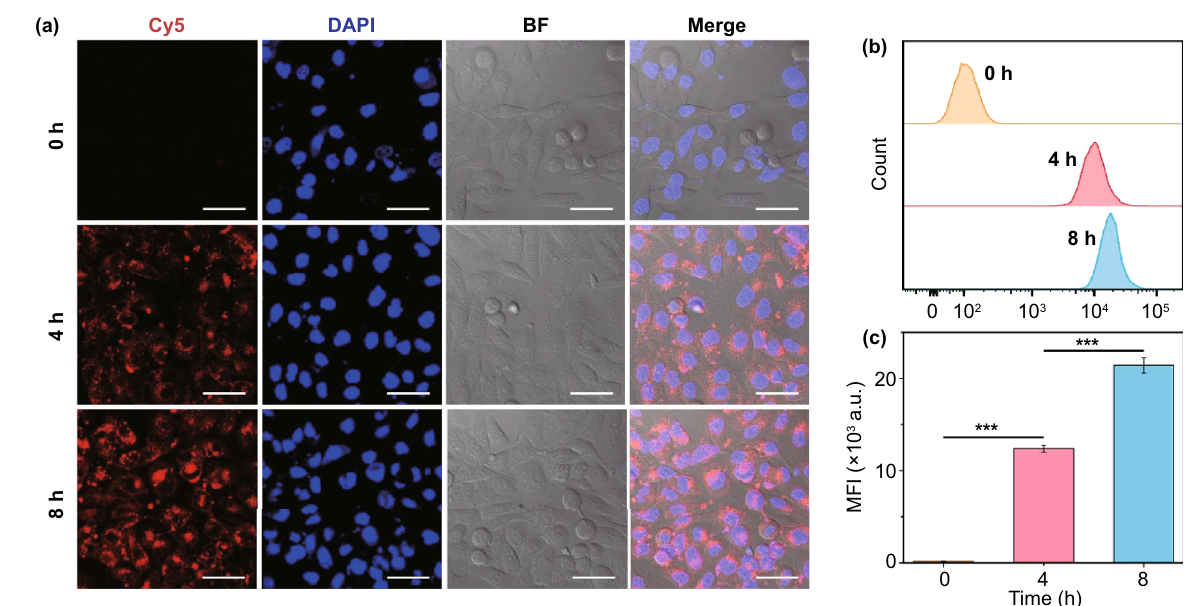
Fig. 2 a CLSM images of Hep3B cells incubated with Cy5 labeled FTP and FTP@RBCM for 4 or 8 h. Scale bar = 50 µm. b Flow cytometry analysis of Cy5 fluorescence inside Hep3B cells. c The corresponding mean fluorescence intensity (MFI) of Cy5 in b ( n =